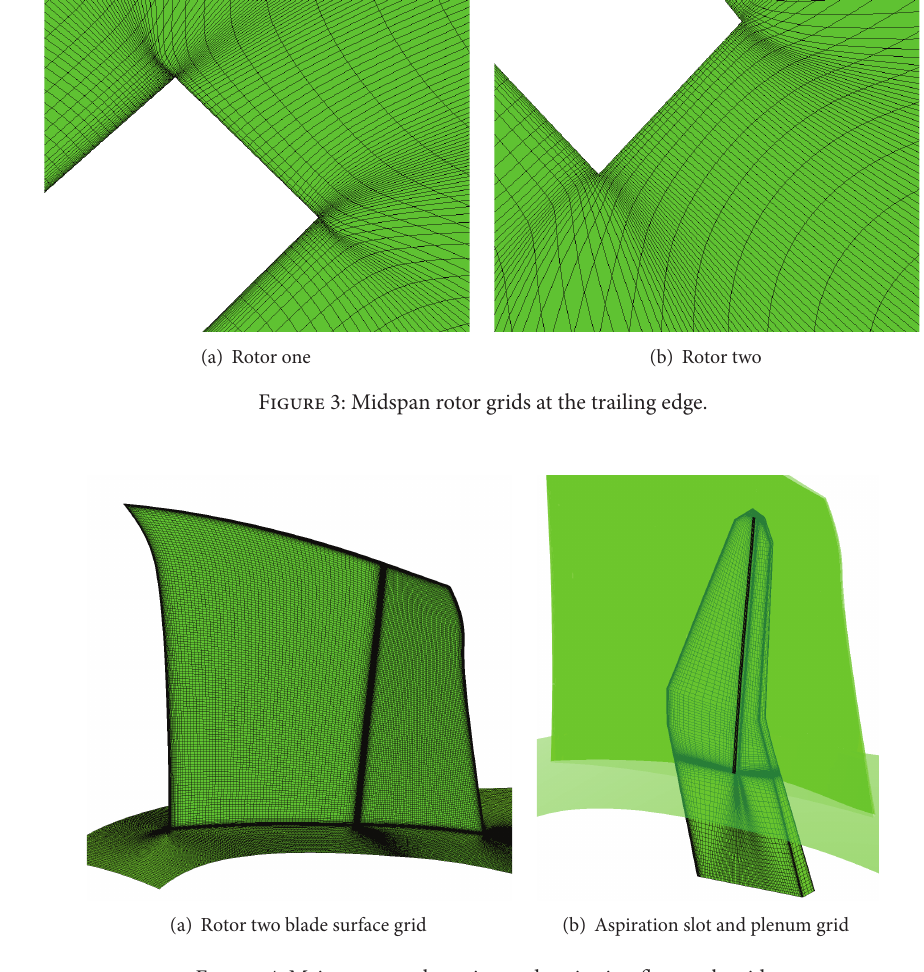
F 4: Main passage clustering and aspiration �ow path